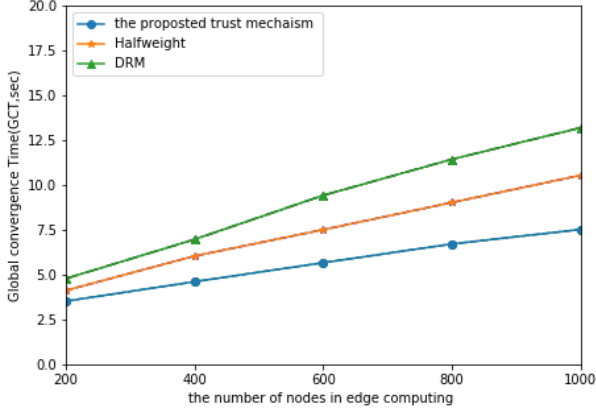
Figure 4. The proportion of MNs is 20% and that of PCN is 20%.